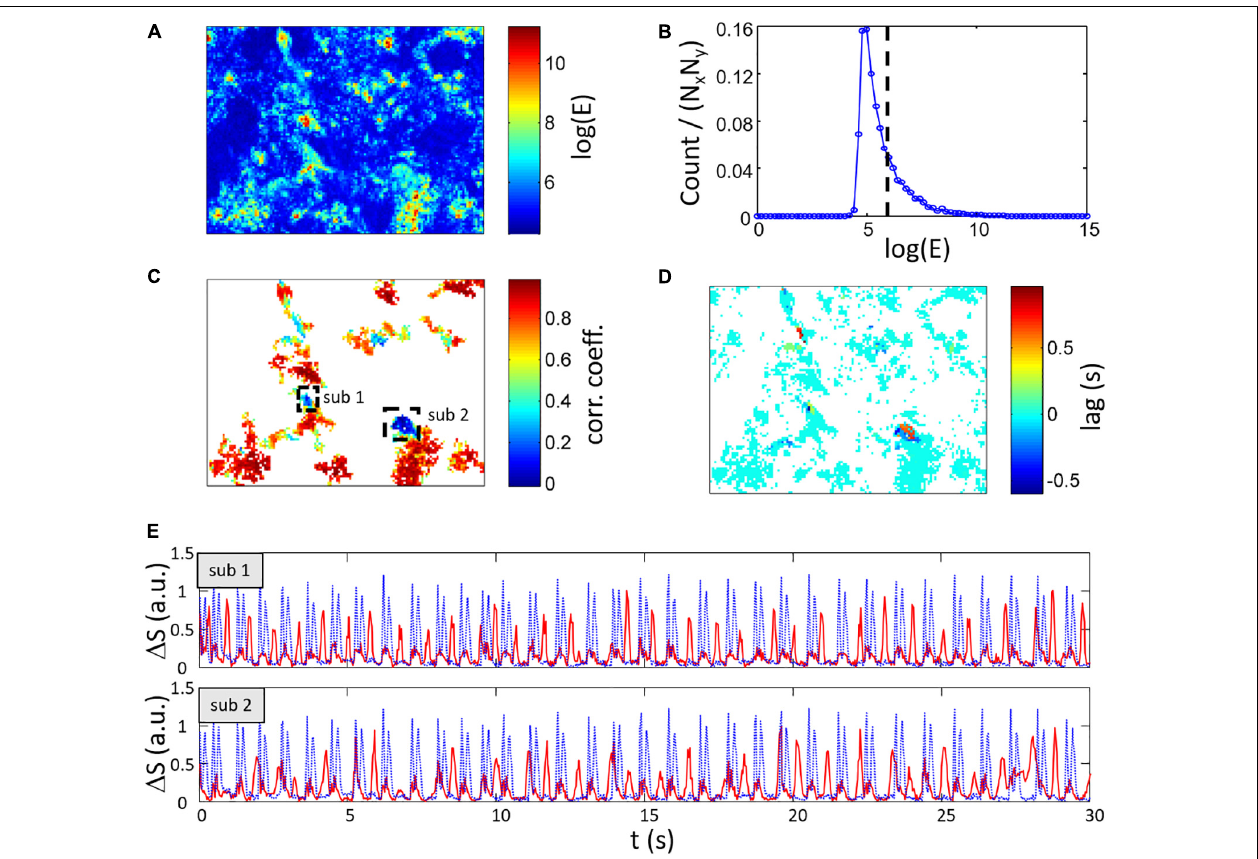
FIGURE 9 | Estimation of heterogeneous spontaneous contraction rhythms within the FOV. (A) Map of log(E) with the energy E calculated from Eq. (4) showing area with no contraction signal in blue. (B) Histogram of log(E) with the dashed line representing the threshold [log(E) > 6] use to select high energy signal regions. (C) Maximum correlation coefficient and (D) lag between local (cid:49) S x (cid:48) , y (cid:48) ( t ) and global (cid:49) S ( t ) for regions having log(E) > 6. Two low CC regions labeled sub 1 and sub 2 are highlighted. Most of the regions show high CC with 0 s lag. (E) Signal from region sub 1 (top axes) and sub 2 (bottom axes) showing the low CC (shown as red lines vs. global (cid:49) S as dotted blue lines) and global (cid:49) S